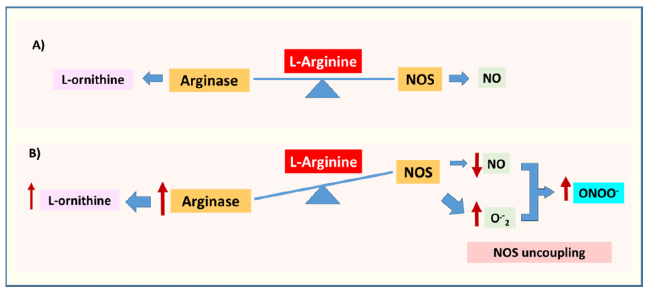
Figure 3. Arginase and Nitric oxide synthase (NOS) uncoupling. ( A ) Under physiological conditions both arginase and NOS compete for the same substrate L-arginine to produce L-ornithine and nitric oxide (NO), respectively. ( B ) Under pathological conditions increased arginase expression/activity can lead to NOS uncoupling and production of superoxide anion O .-2 , which can react with NO to produce peroxynitrite (ONOO − ). The figure is simplified to show the inverse relation between arginase and NOS.